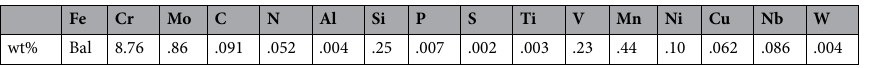
Table 2. Chemical compositions (wt%) of T91 heat 30176 provided by PNNL and Luvak; reproduced from Ref. 19